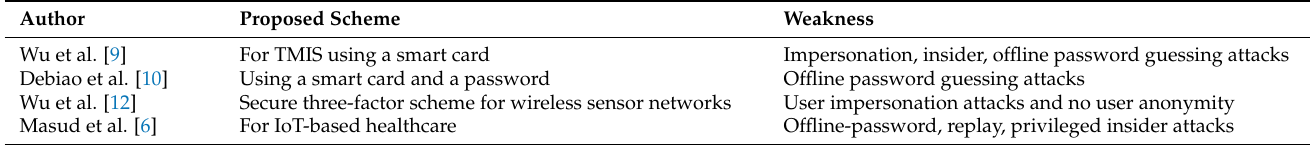
Table 1. Summary of related